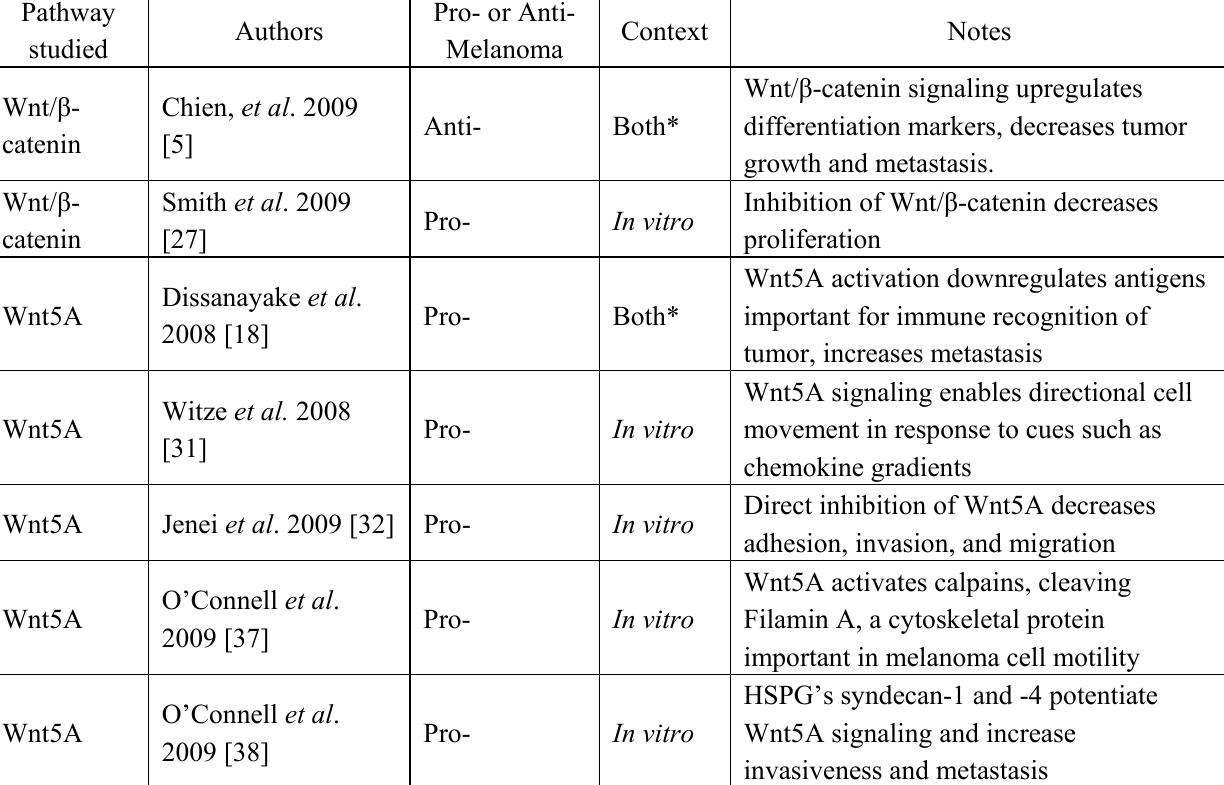
Table 1. Studies implicating activated morphogen pathways in melanoma